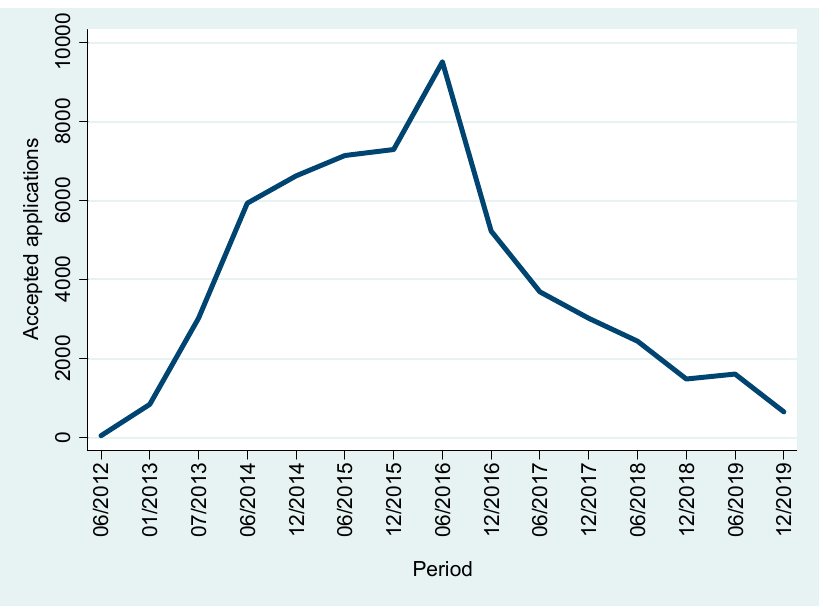
Figure 6. Applications accepted by the financial institutions adhering to the Code of Good Practice regulated by the Royal Decree-Law 6/2012. The data source is the report from the Commission monitoring the Code of Good Practice.